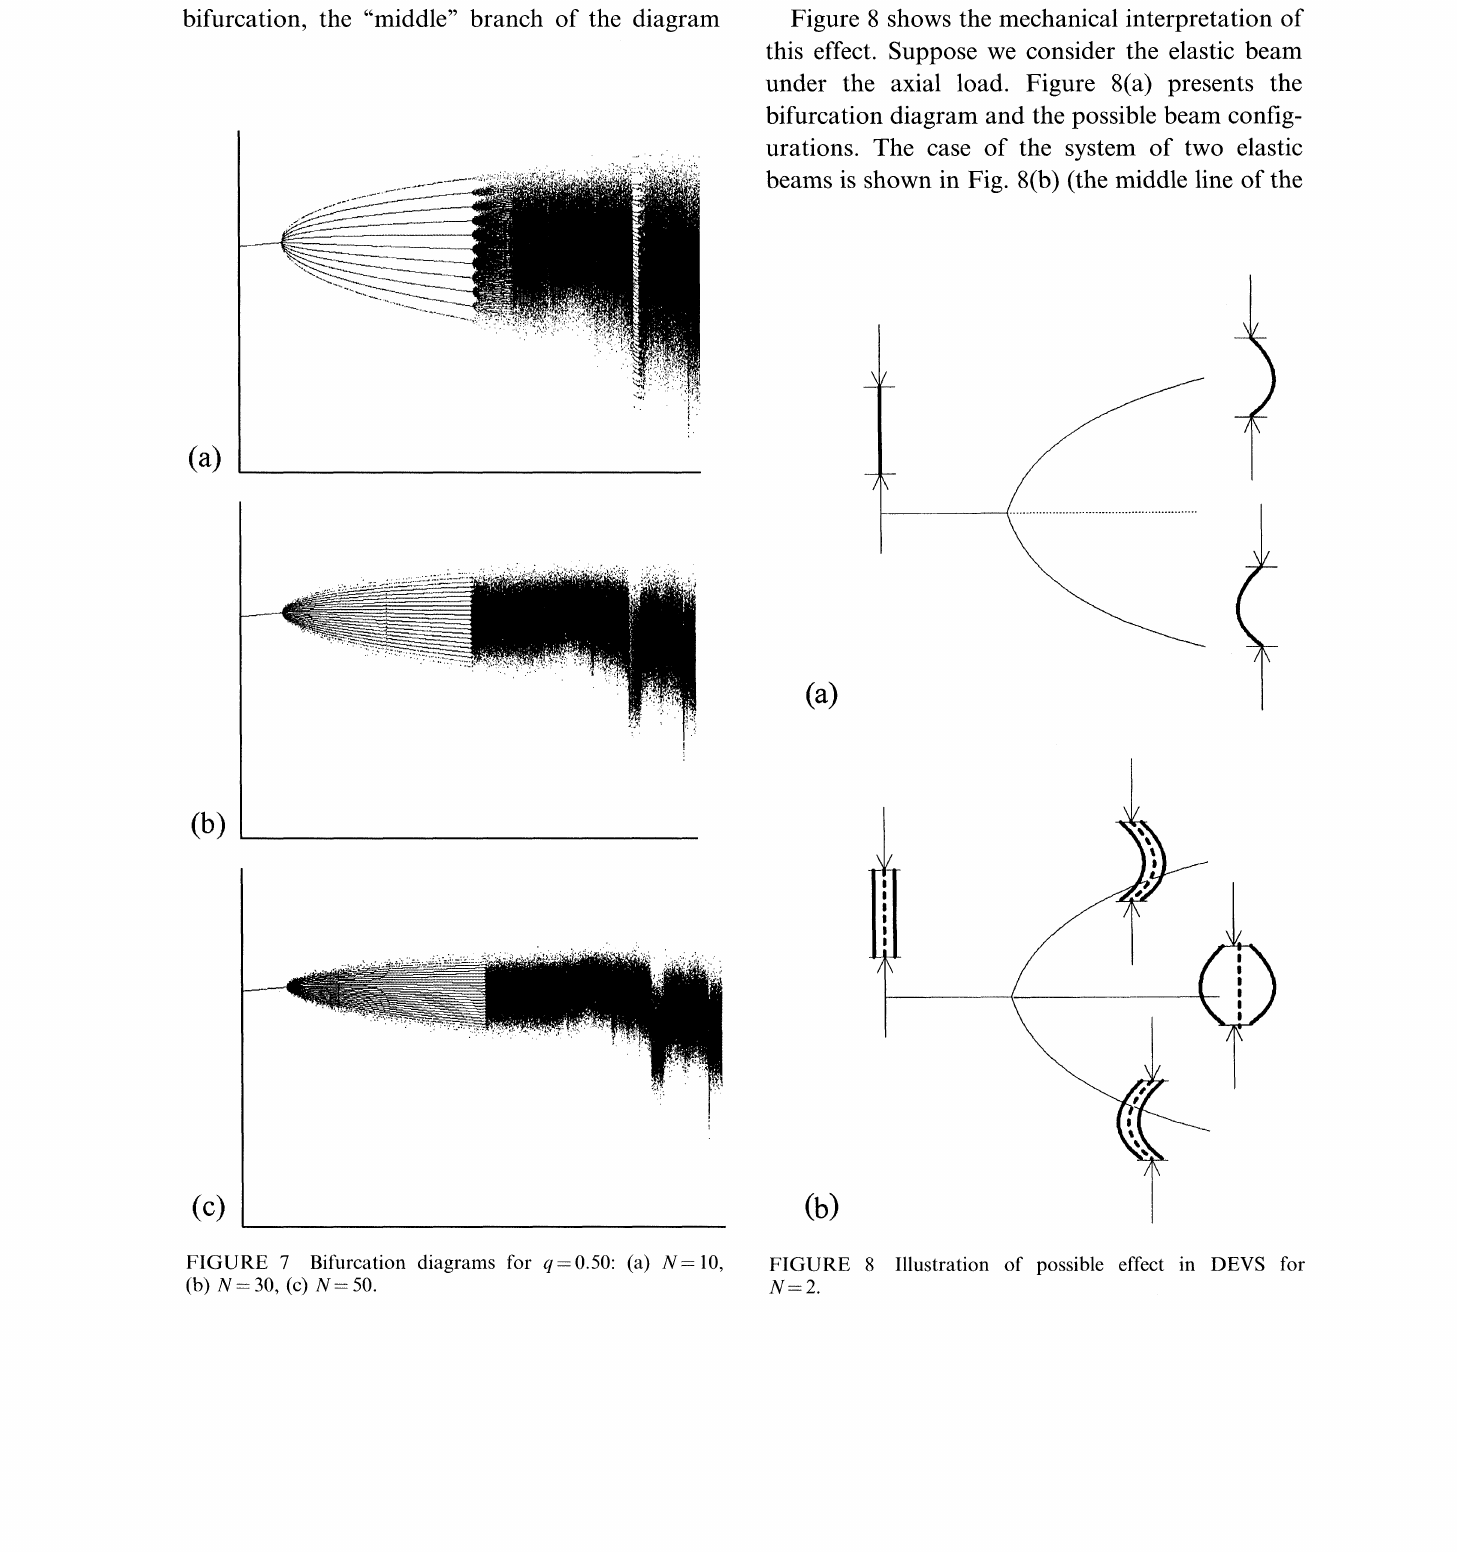
FIGURE 8 Illustration of possible effect in DEVS for